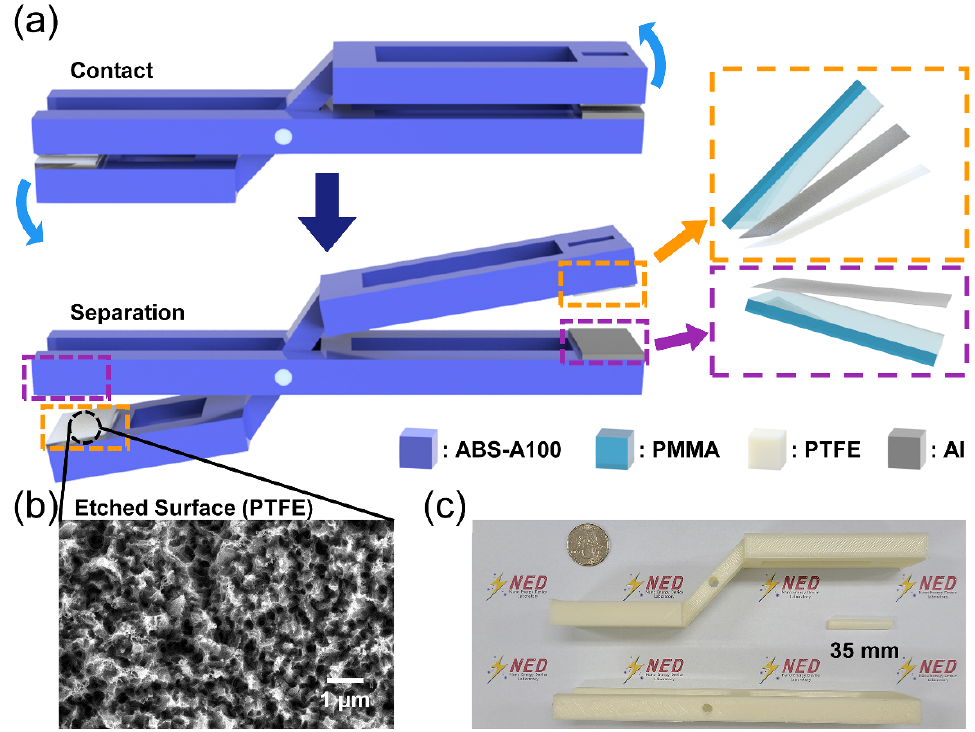
Figure 1. ( a ) Structural illustration of the lever-based TENG (L-TENG). ( b ) PTFE surface with ICP etching. ( c ) A digital camera image of the 3D printed flat L-TENG device. etching. ( c ) A digital camera image of the 3D printed flat L-TENG Both the left and right TENG parts are divided into two parts, as indicated by purple- colored and orange-colored boxes in Figure 1a. The purple-colored box illustrates the sub- strate and the outer electrode. A PMMA plate was used as a flat substrate and Al tape was attached to the substrate. The orange-colored box is similar to the purple-colored box, but a 200 µm-PTFE layer is additionally attached to the electrode layer as a dielectric layer of the TENG. These two outermost layers are in states of contact and separation with rota- tional motion of the printed structure.